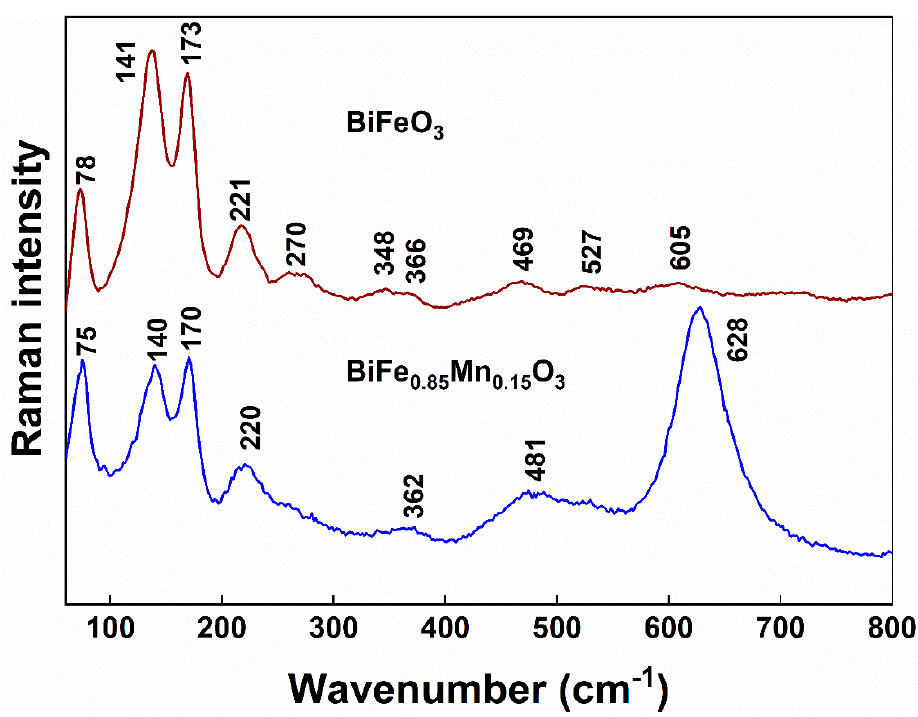
Figure 3. Raman spectra of polycrystalline BiFeO 3 and BiFe 0.85 Mn 0.15 O 3 samples in the frequency region of 60 − 800 cm − 1 . The excitation wavelength is 532 nm (0.2 mW). Doping with Mn 3+ ions results in drastic changes in the Raman spectrum (Figure